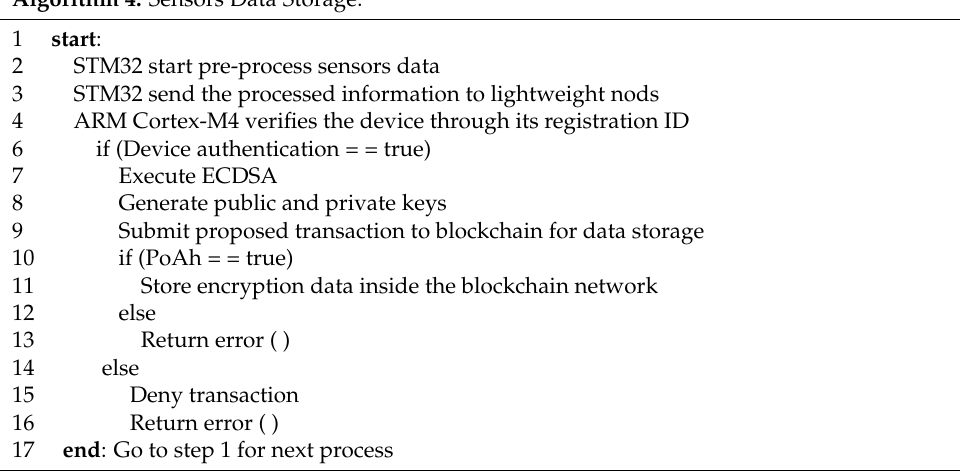
Figure 3. Collecting and storage process of sensor data. Algorithm 4. Sensors Data